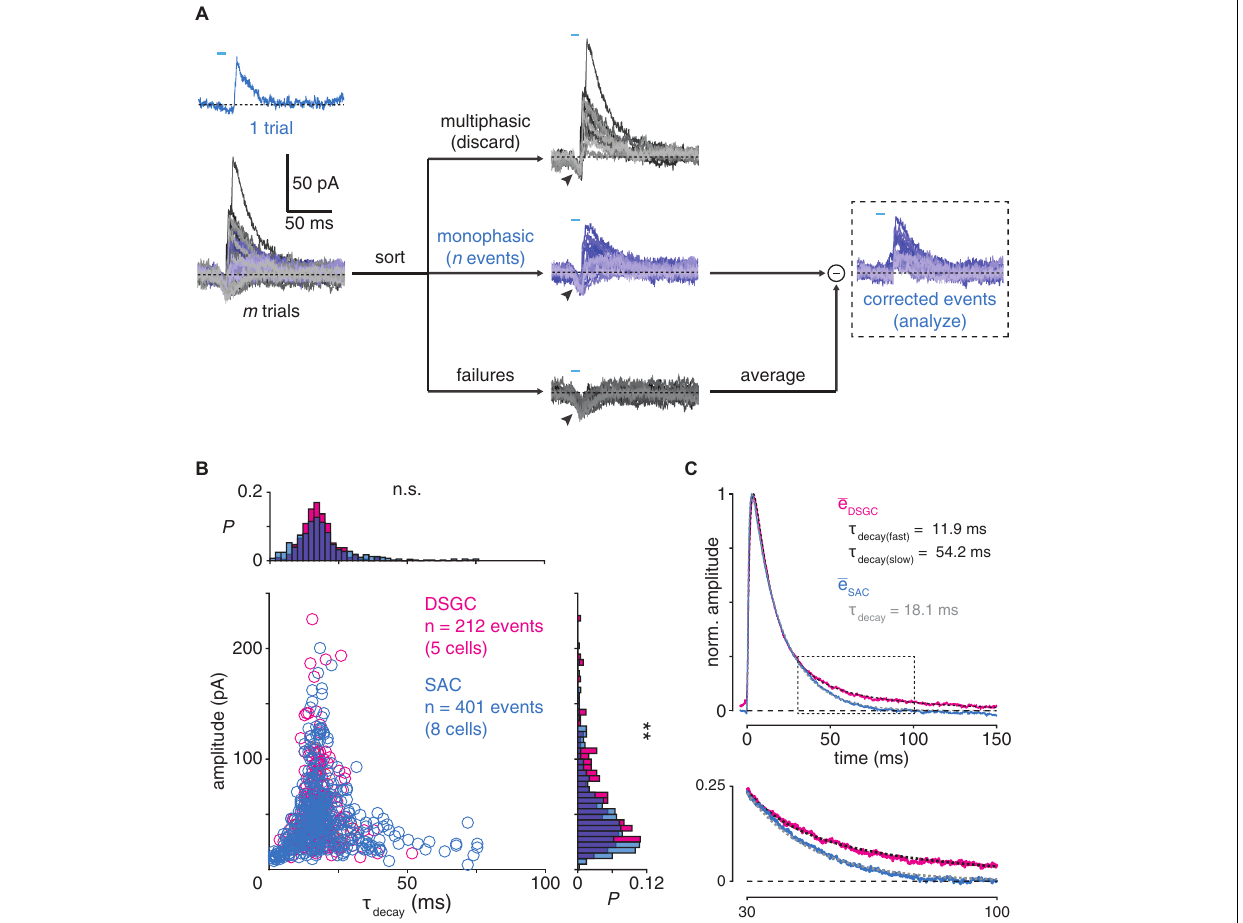
FIGURE 5 | Postsynaptic filtering at GABAergic SAC synapses. (A) Generation of evoked monophasic inhibitory postsynaptic currents (emIPSCs) in an ON SAC. Brief ( < 10 ms) optogenetic stimulation of presynaptic SACs evokes a small, monophasic IPSC (blue). Following m trials, n monophasic events are distinguished from multiphasic events and failures (gray). Arrowheads indicate unclamped ChR2-mediated photocurrents, which are removed by subtracting the mean of all failures from each emIPSC. (B) Comparison of emIPSCs recorded in DSGCs and ON SACs. Amplitude plotted against decay time constant ( τ decay ) for emIPSCs recorded in DSGCs ( n = 212 events from 4 ON-OFF DSGCs and 1 ON DSGC) and ON SACs ( n = 401 events from 8 cells). Marginal probability distributions of emIPSC amplitude and τ decay are shown at right and above, respectively. (C) Averaged time courses of emIPSCs recorded in DSGCs and ON SACs. Top , average of all emIPSCs recorded in DSGCs ( ¯ e DSGC , magenta trace) is fit by a function (dashed black trace; see section “Materials and Methods”) with two exponential decay terms ( τ decay ( fast ) = 11.9 ms; τ decay ( slow ) = 54.2 ms). Overlaid, the average of all emIPSCs recorded in SACs ( ¯ e SAC , blue trace) is fit by a similar function with a single exponential decay term (dashed gray trace; τ decay = 18.1 ms). All traces are normalized to their respective maxima. Bottom , expanded view of boxed period above. Data from DSGCs is re-plotted from Pottackal et al. (2020). n.s., not significant; ** p <